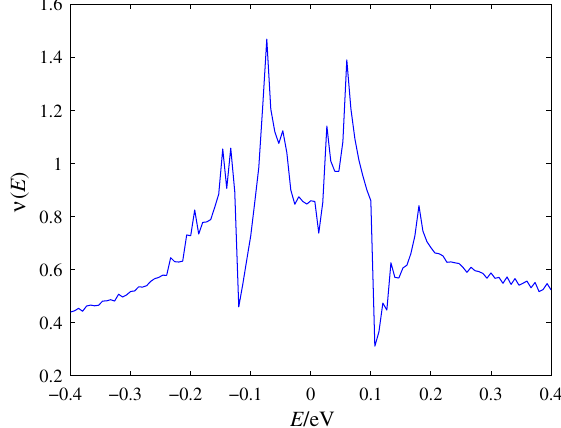
FIG. 5. Plot of the tunneling density of state ν ð E Þ for the same parameters as in Fig. 3.